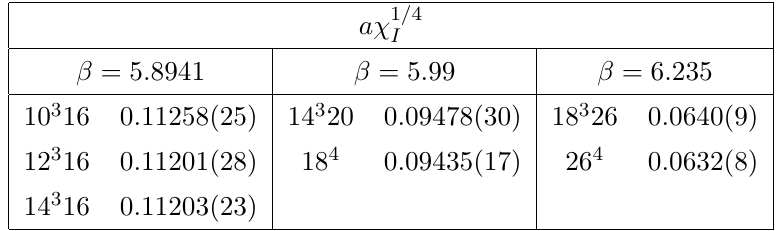
Table 23 . The topological susceptibility, χ I , on different space-time volumes at the values of β